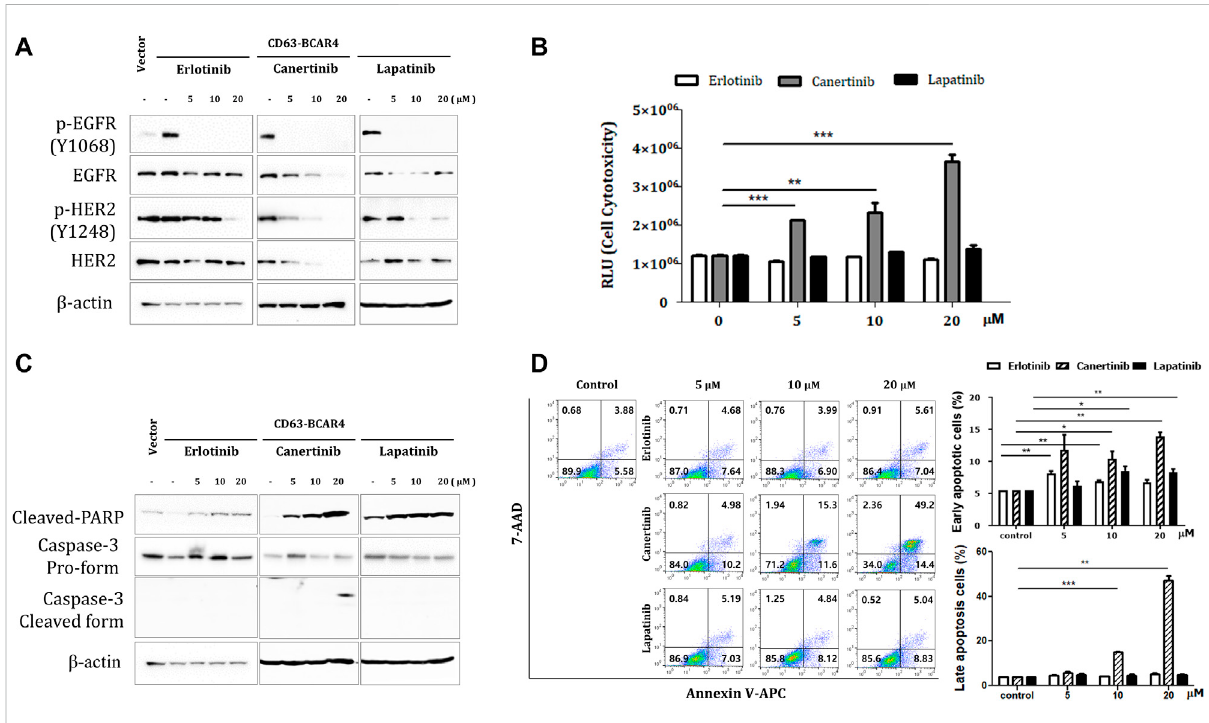
FIGURE 4 Inhibitory effects of TKIs on CD63-BCAR4. (A) Protein levels of EGFR, HER2, and their phosphorylated forms were examined after the indicated drug treatments. (B) The cytotoxicity of each drug was assessed up to a high concentration. Data represents mean ± SD of luminescencevalues(RLU). Statistical signi fi cancesare marked with** ( p < 0.005)and *** ( p < 0.0005). RLU, relative light unit. (C) Cleaved-PARP and caspase-3 protein were examined using western blot analysis. (D) Apoptosis was assessed using annexin V and 7-AAD staining. The representative images of fl ow cytometry pro fi les are shown. Early apoptosis was examined using annexin V + /7-AAD - cells. Late apoptotic and dead cells were annexin V + /7-AAD + . Replicated experiments were performed and statistical signi fi cance are marked with * ( p < 0.05), ** ( p < 0.005), and *** ( p <